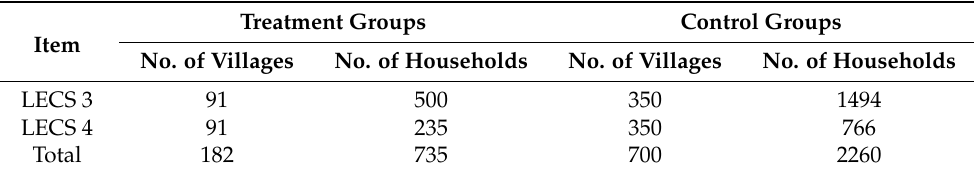
Table 1. Sample size.